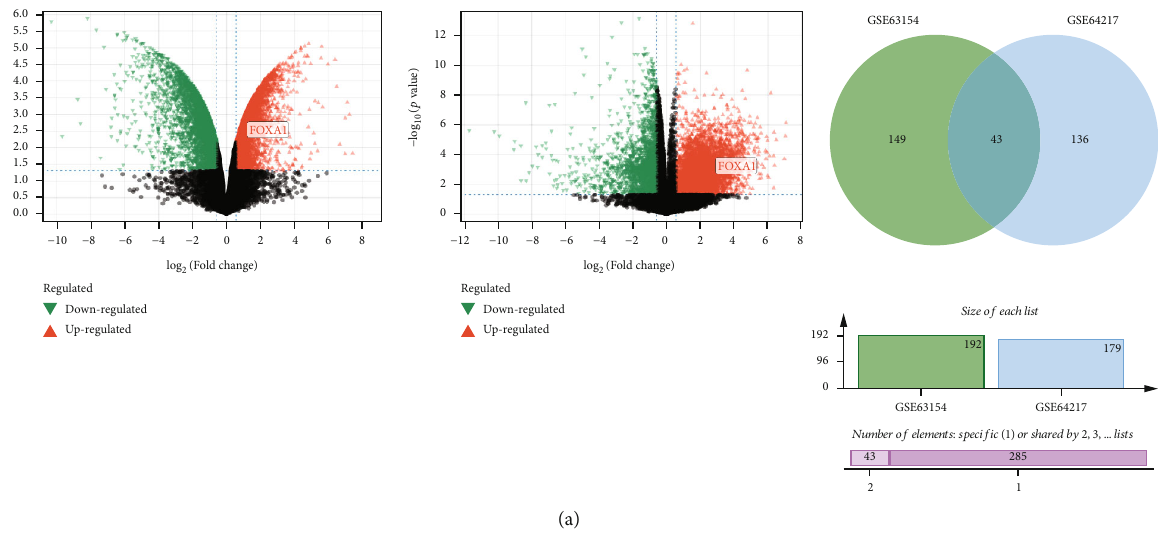
The gene expression profile across all tumor samples and paired normal tissues. (Dot plot) Each dots represent expression of